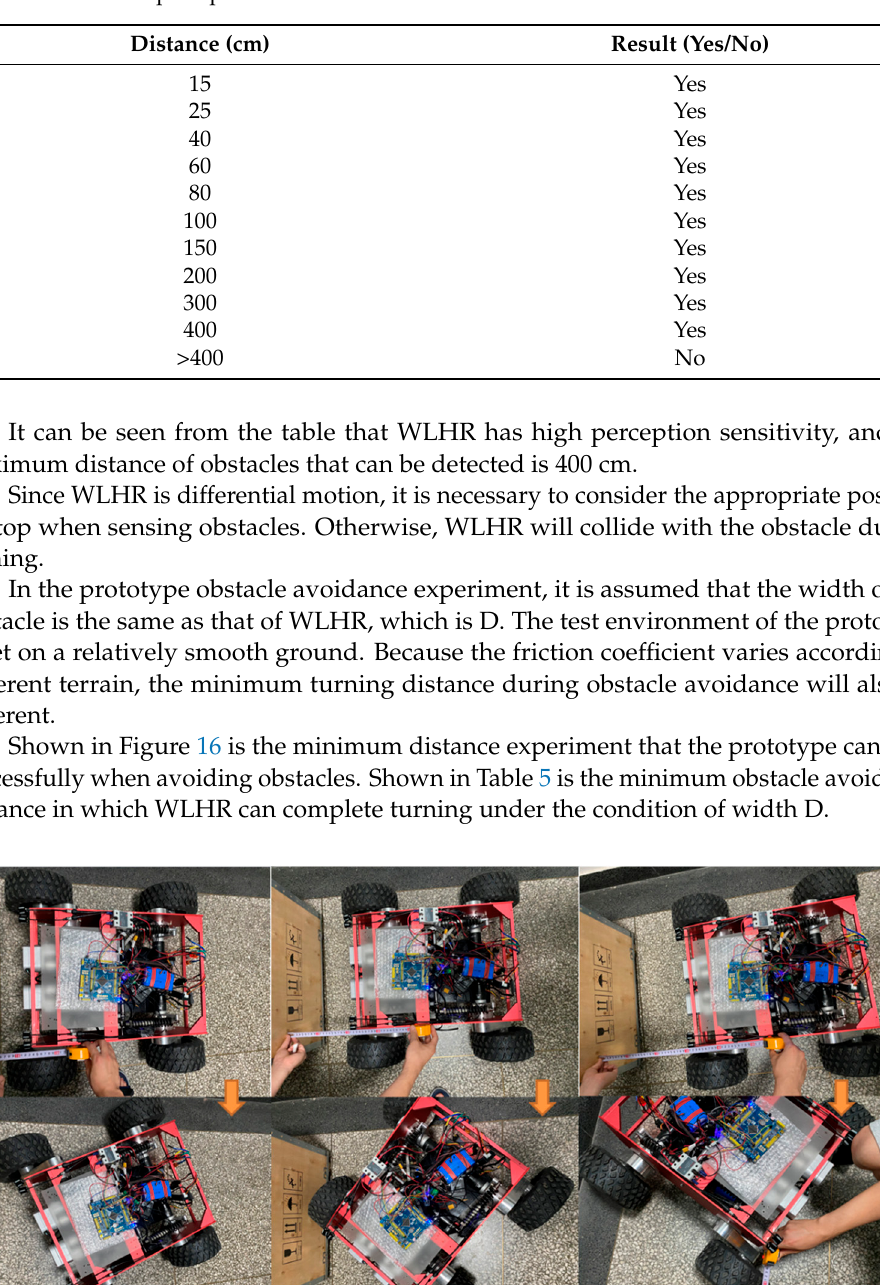
Table 4. Distance of perceptible obstacles.